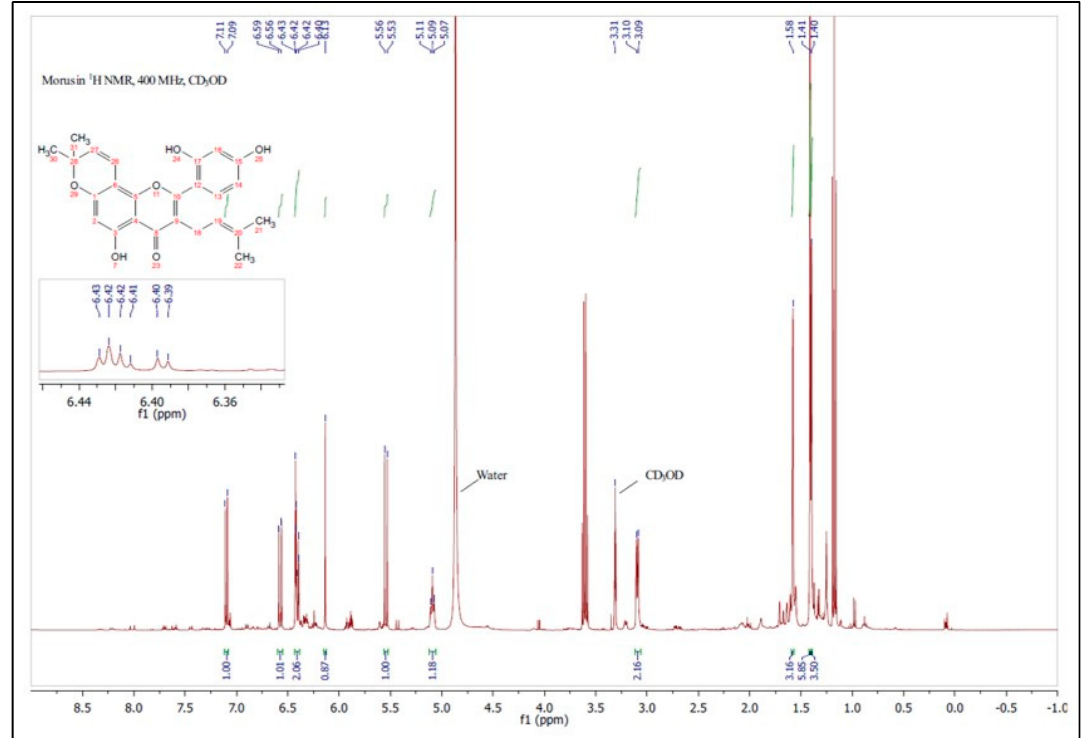
Figure A4. 1 H-NMR (400 MHz, CD 3 OD) spectrum of the compound Kuwanon C.